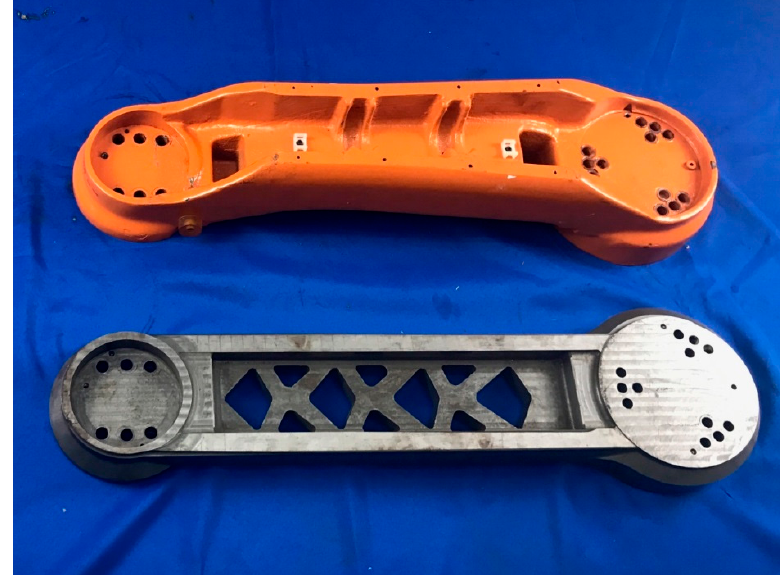
Figure 27. The actual upper arm products before and after optimization.